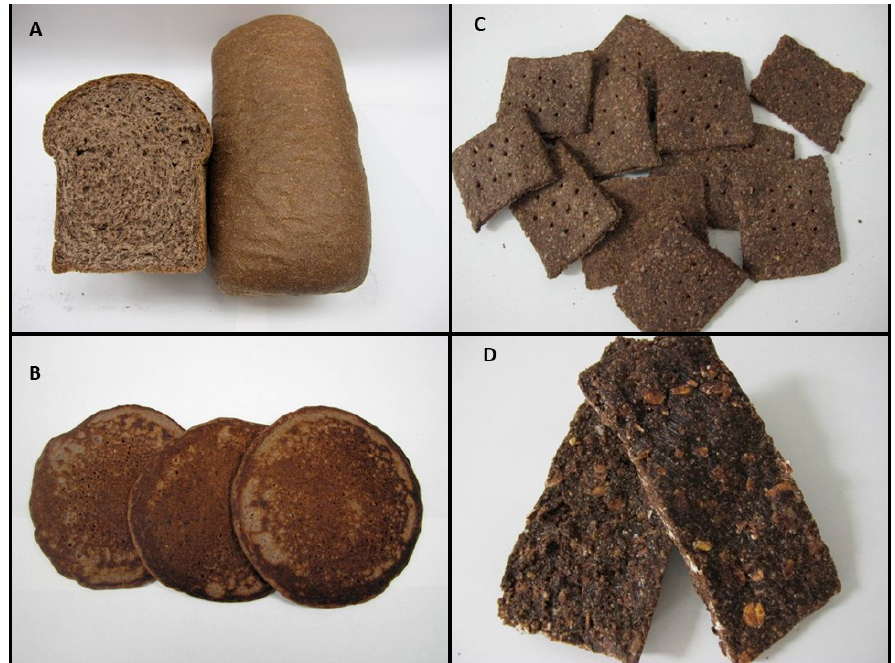
Figure 2. Selected food products made from wholegrain purple wheat: ( A ) Bread, ( B ) Pancakes, ( C ) Bran-enriched crackers, and ( D ) Bran-enriched convenience bars. Crackers and convenience bars were assessed in human studies.